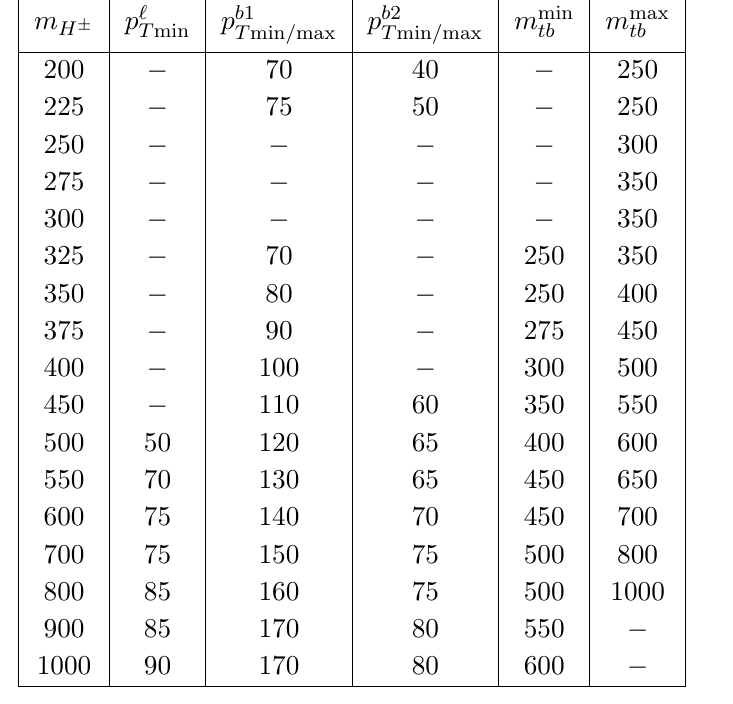
(cid:20) 1000 GeV. All H (cid:6)